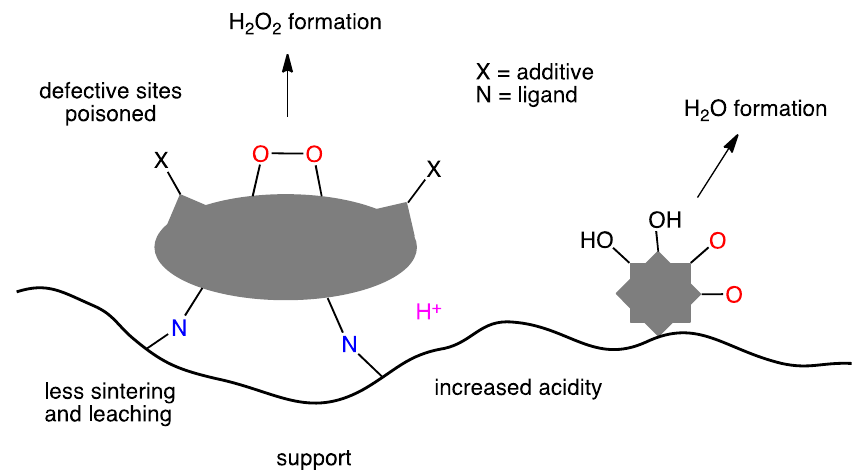
Figure 9. Roles of surface morphology and additives.